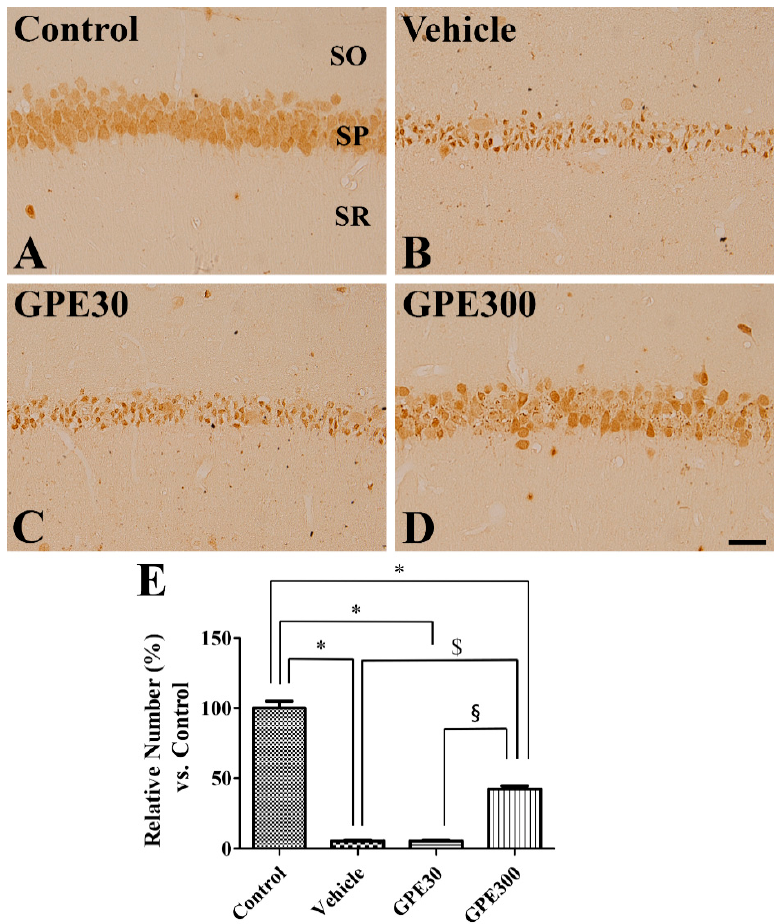
Figure 3. Immunohistochemistry for NeuN in the CA1 region of the control ( A ), vehicle-treated ischemic (Vehicle, B ), 30 mg/kg GPE-R-treated ischemic (GPE30, C ), and 300 mg/kg GPE-R-treated ischemic (GPE300, D ) groups. SO, stratum oriens; SP, stratum pyramidale; SR; stratum radiatum. Scale bar = 50 μ m. ( E ) The number of NeuN-immunoreactive neurons per section in the hippocampal CA1 region of each group compared with the control group, is shown ( n = 7 per group, * p < 0.05 vs. the control group; $ p < 0.05 vs. the vehicle group; § p < 0.05 vs. the GPE30 group). Error bars represent standard errors of the means.